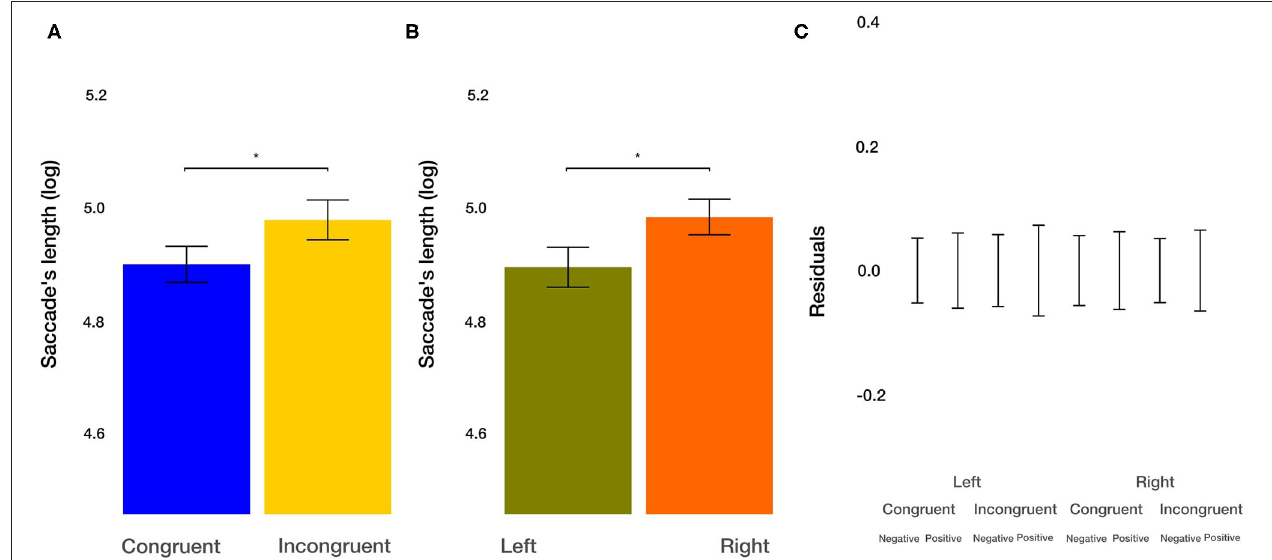
FIGURE 8 | Saccade’s length from outside ROIs toward ROIs results. (A) The main effect of the congruency of the priming. (B) The main effect of the side of the image (left vs. right). (C) Averaged residuals of all condition combinations from the saccade’s length from outside ROIs toward ROIs linear mixed model. In all plots, bars represent mean values and whiskers standard error of the mean. Stars represent significance levels: * p < 0.05, ** p < 0.01, and *** p <